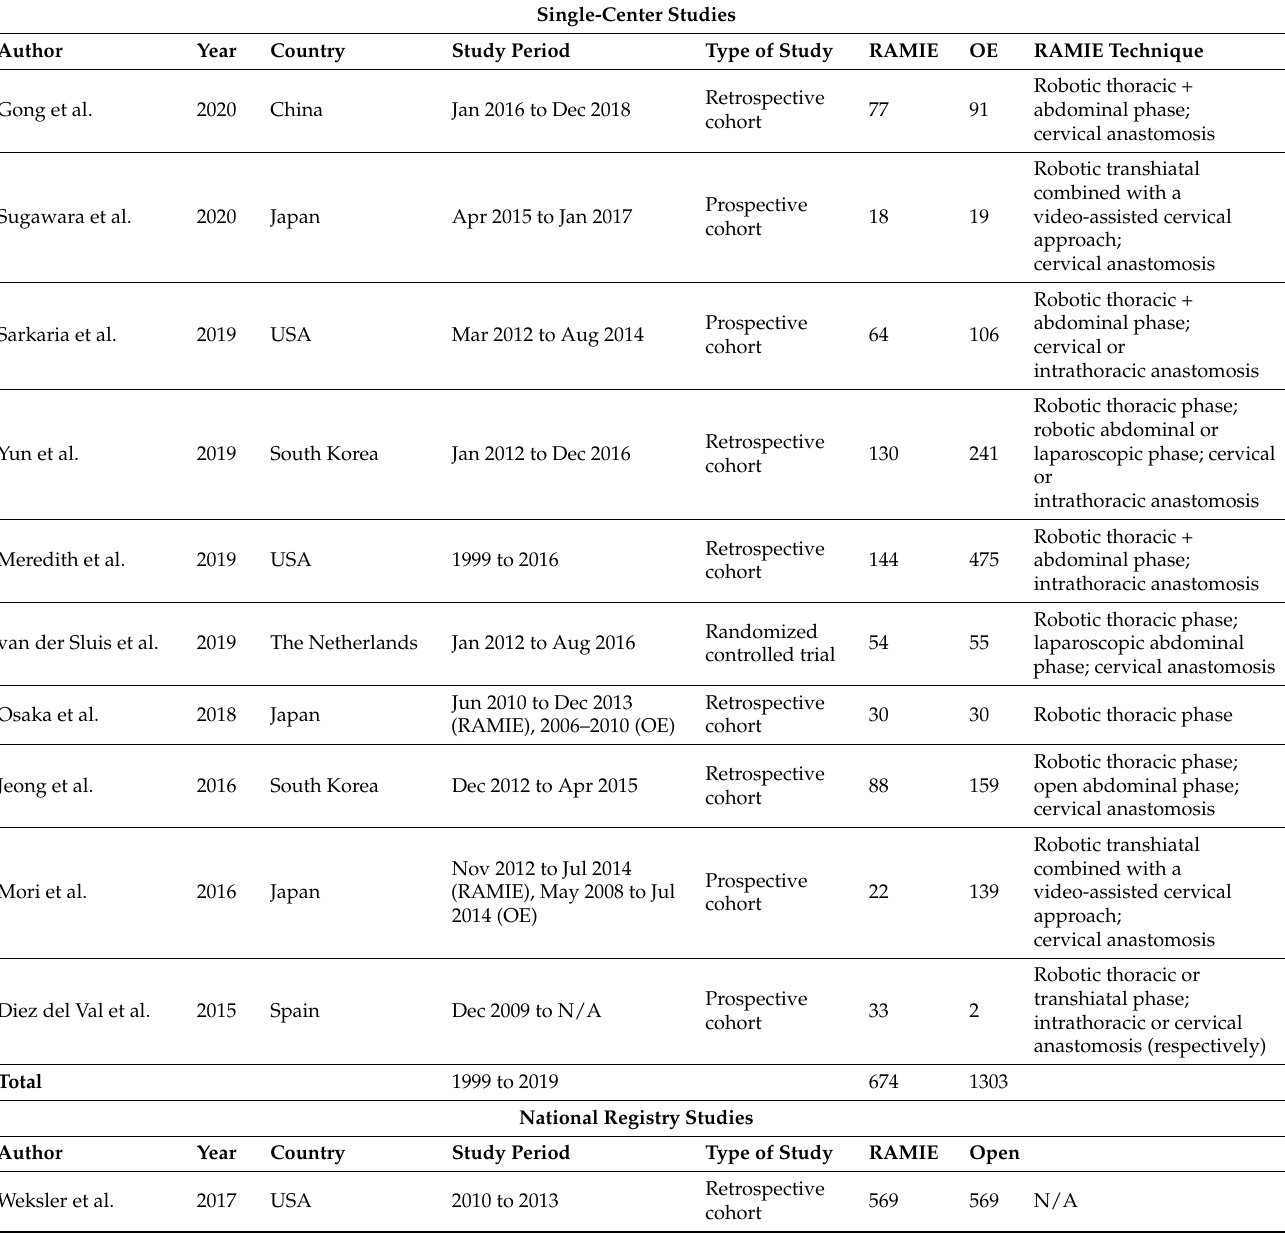
Table 1. Characteristics of the included